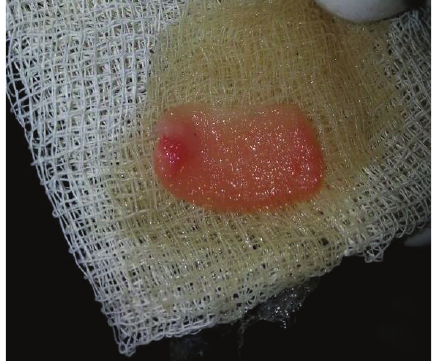
Figure 2: Access opening for pulpotomy procedure.